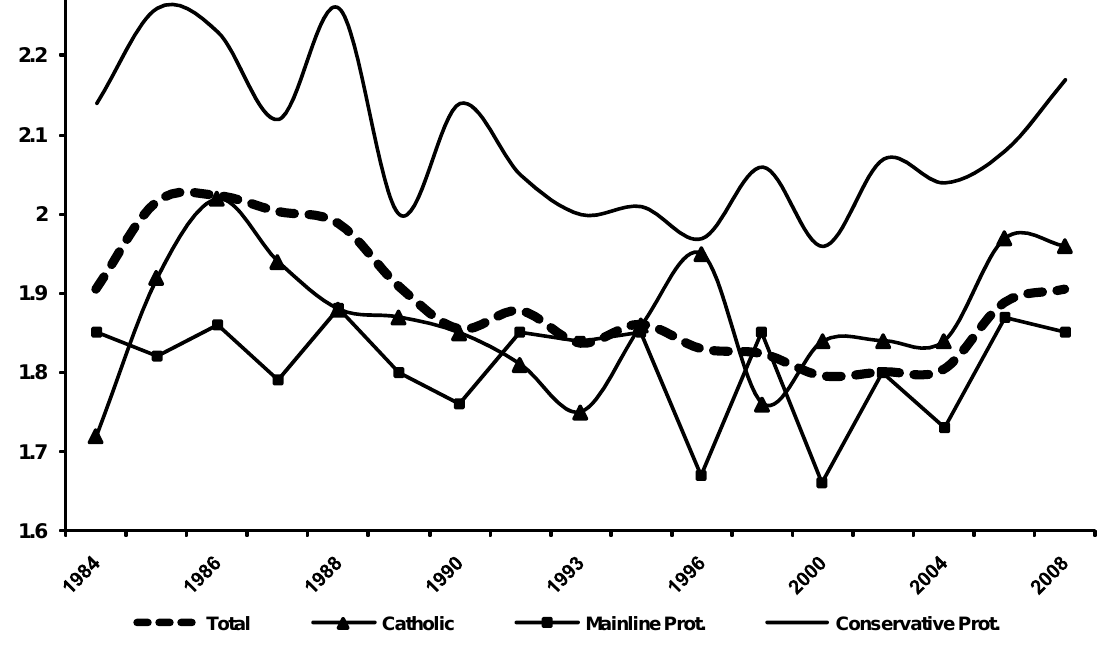
Figure 1: Average Reported Number of Children by Year and by Religious Figure 1. Average Reported Number of Children by Year and by Religious Group.